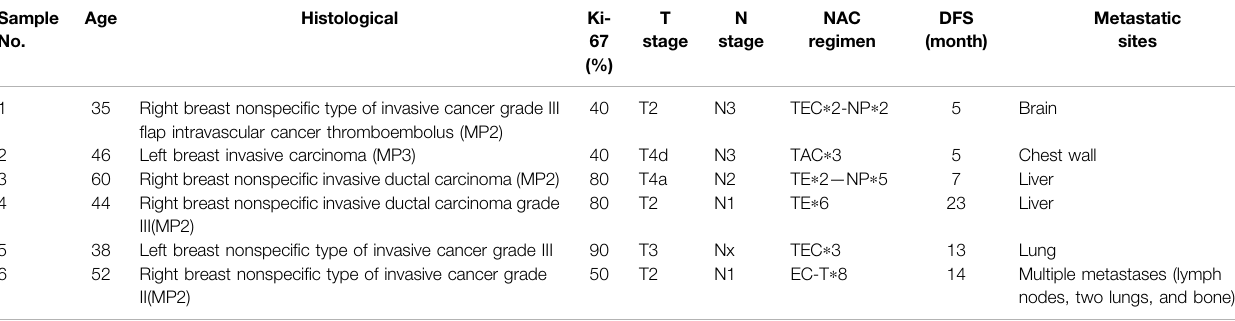
TABLE 1 | Detailed clinical information of six patients. Sample